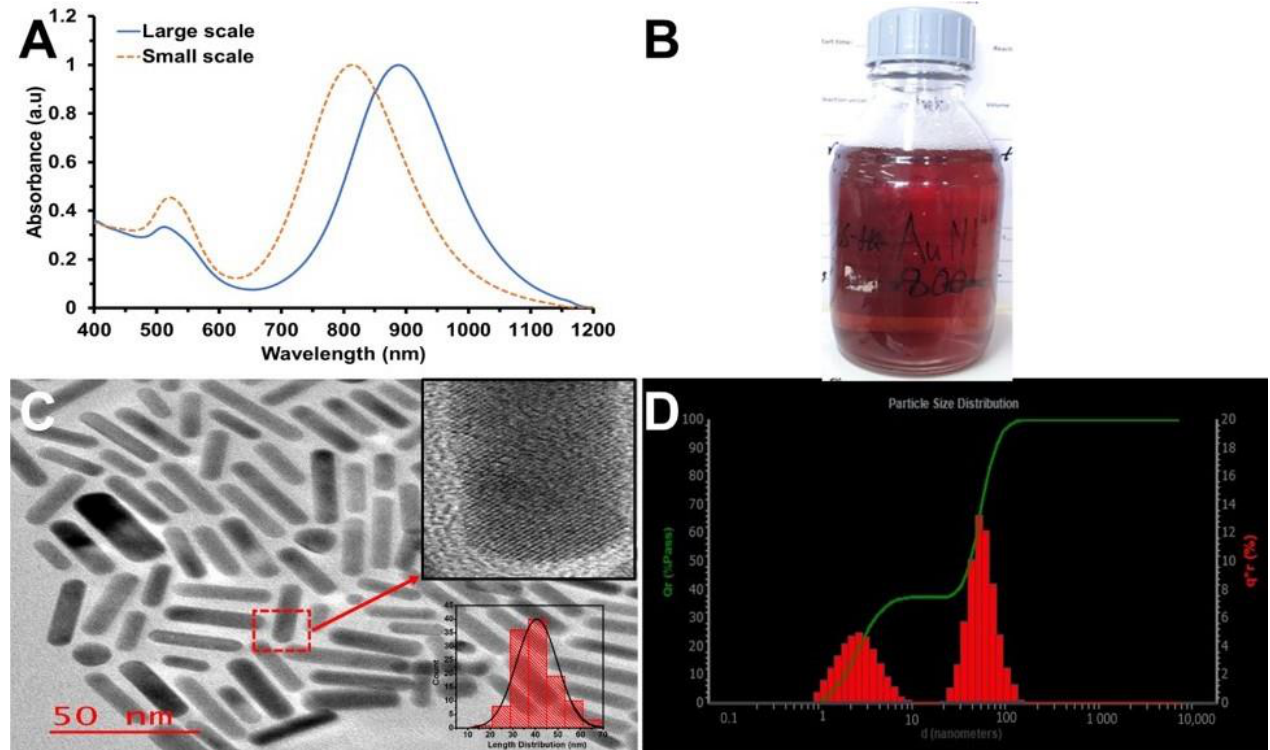
Figure 4. ( A ) UV-Vis-NIR spectra of large- and small-scale synthesized AuNRs. ( B ) Photographic image of large-scale (500 mL) synthesized AuNRs. ( C ) TEM image of AuNRs synthesized at a large scale (Scale: 50 nm); inset: HRTEM image of large-scale synthesized AuNRs. ( D ) DLS size distribution graph of large-scale synthesized AuNRs.